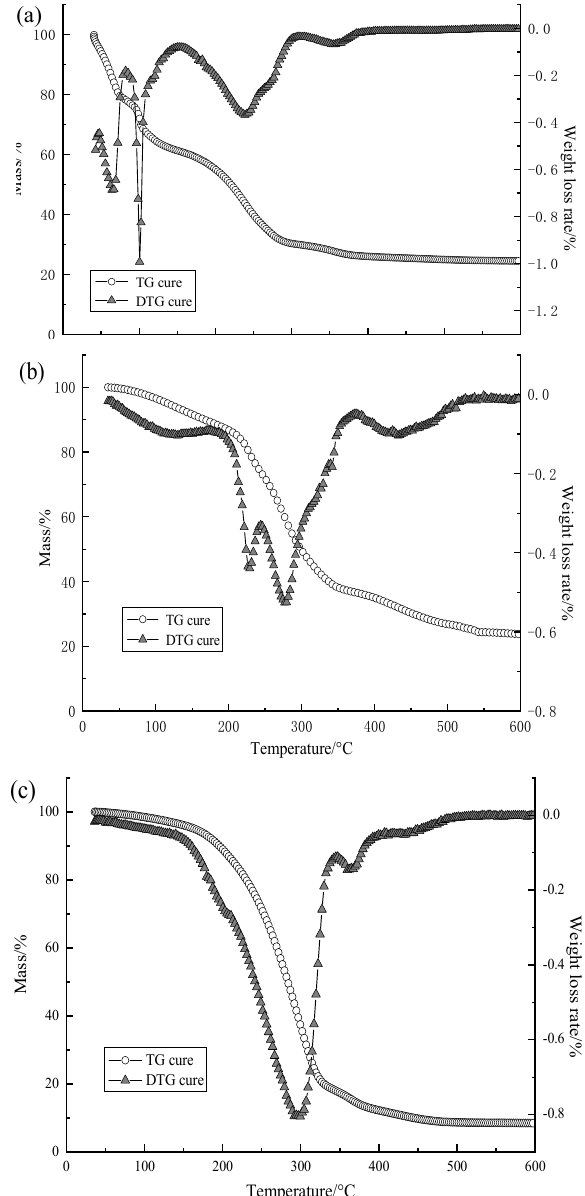
Figure 11. TG analysis of ( a ) W/O/W multiple emulsion; ( b ) calcium alginate shell; and ( c ) STF capsule.